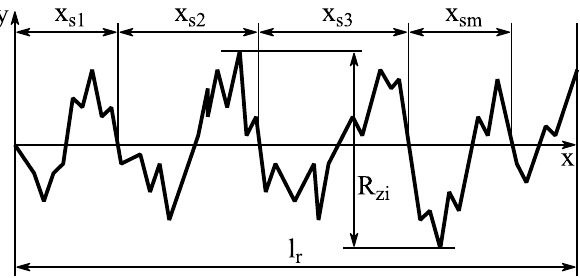
Figure 6. Schematic representation of the surface profile.